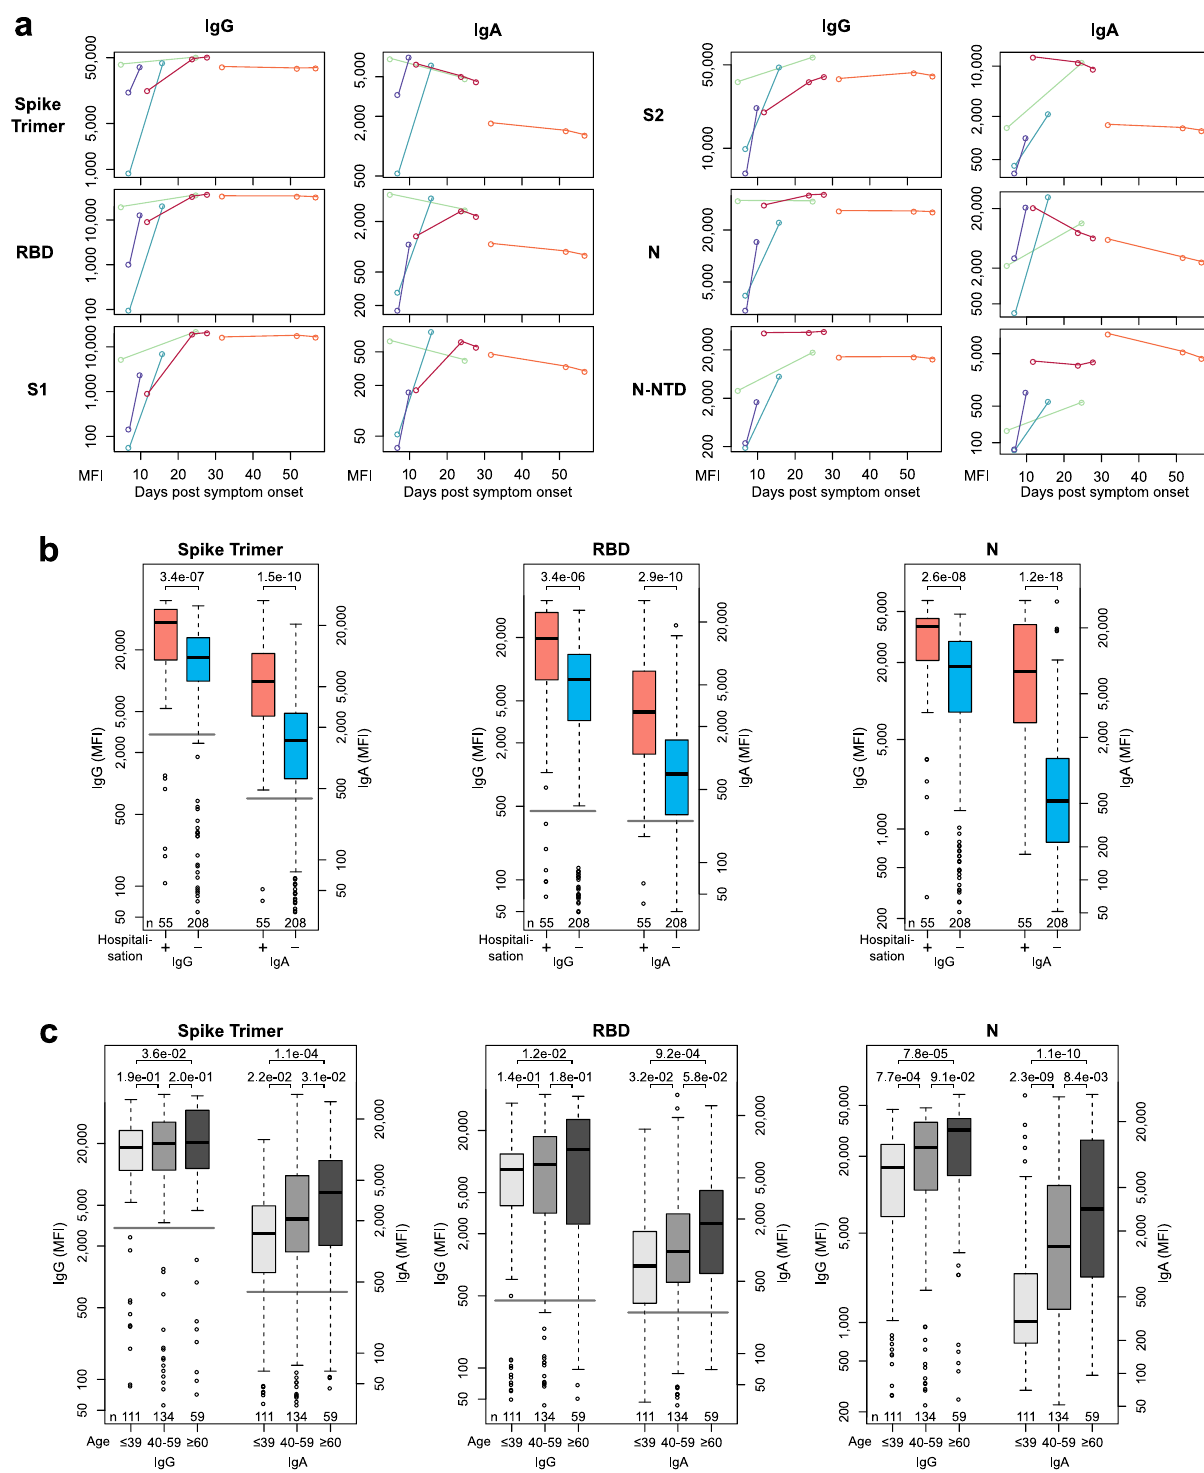
Fig. 3 Multiplex-based seropro fi ling allows in-depth characterization of SARS-CoV-2 antibody responses. a Kinetic of SARS-CoV-2 antigen-speci fi c IgA and IgG responses is shown for indicated days after symptom onset for six SARS-CoV-2-speci fi c antigens for fi ve different patients. Patients are indicated by color. b , c Samples of SARS-CoV-2-infected individuals were analyzed to identify antigen- and isotype-speci fi c antibody responses based on hospitalization indicating disease severity ( b ) or age ( c ). Data is presented as Box-Whisker plots of sample MFI on a logarithmic scale. Box represents the median and the 25th and 75th percentiles, whiskers show the largest and smallest values. Outliers determined by 1.5 times IQR of log-transformed data are depicted as circles. p -value (Mann – Whitney U test, two-sided) is displayed at the top of the boxes, indicating differences between signal distribution for respective groups. Cut-off values for MultiCoV-Ab classi fi cation are displayed as horizontal lines (Spike Trimer IgG: 3,000 MFI, IgA: 400 MFI; RBD IgG: 450 MFI, IgA: 250 MFI). Source data are provided as a Source Data fi